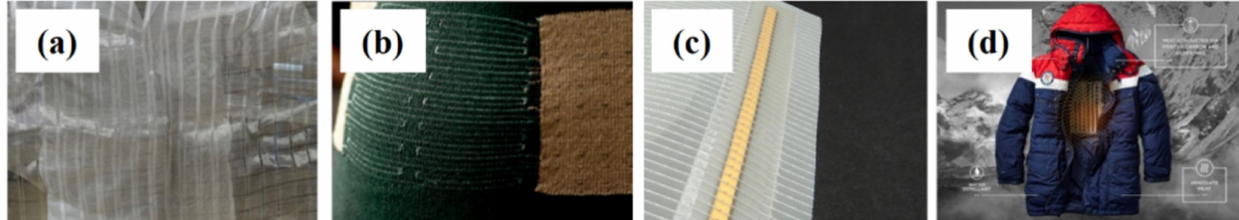
Figure 1. Examples of textiles based on heating elements with metal wires and Surface heating elements (SHEs): ( a ) a metal heating element, ( b ) Warm X, ( c ) SEFAR Power Heat, and ( d ) novel outdoor warm